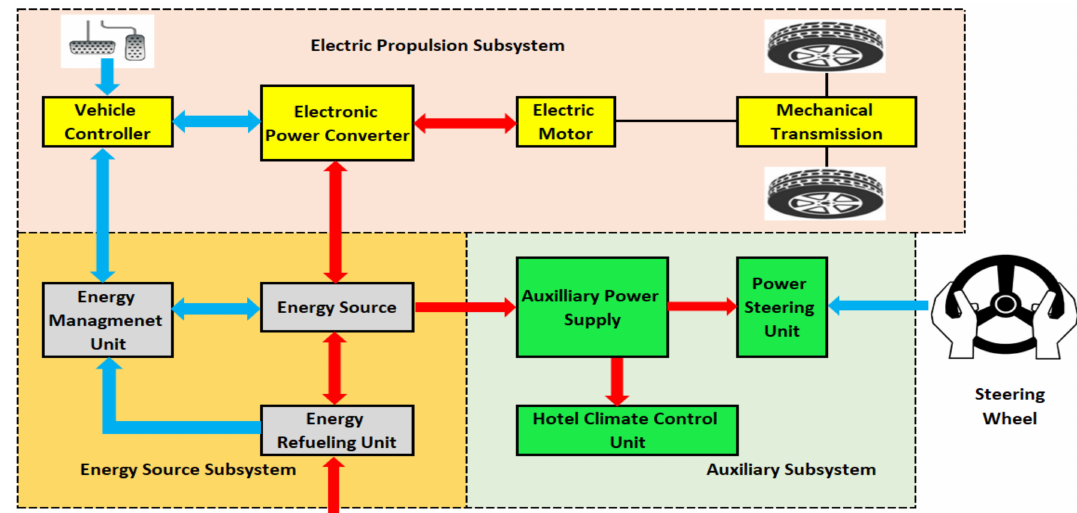
Figure 2. Illustrative configuration of general electric vehicles (EVs)